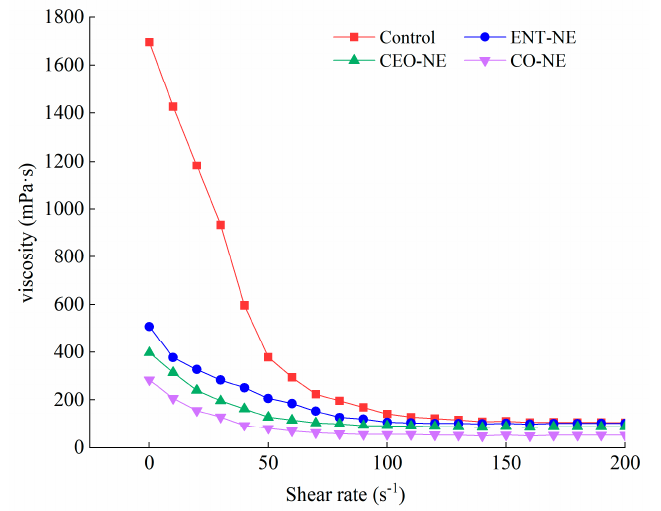
Figure 2. The viscosity of nanoemulsions containing enterocin Gr17 alone (ENT-NE), cinnamaldehyde alone (CEO-NE), enterocin Gr17 and cinnamaldehyde (CO-NE) and no enterocin Gr17/cinnamaldehyde (Control).